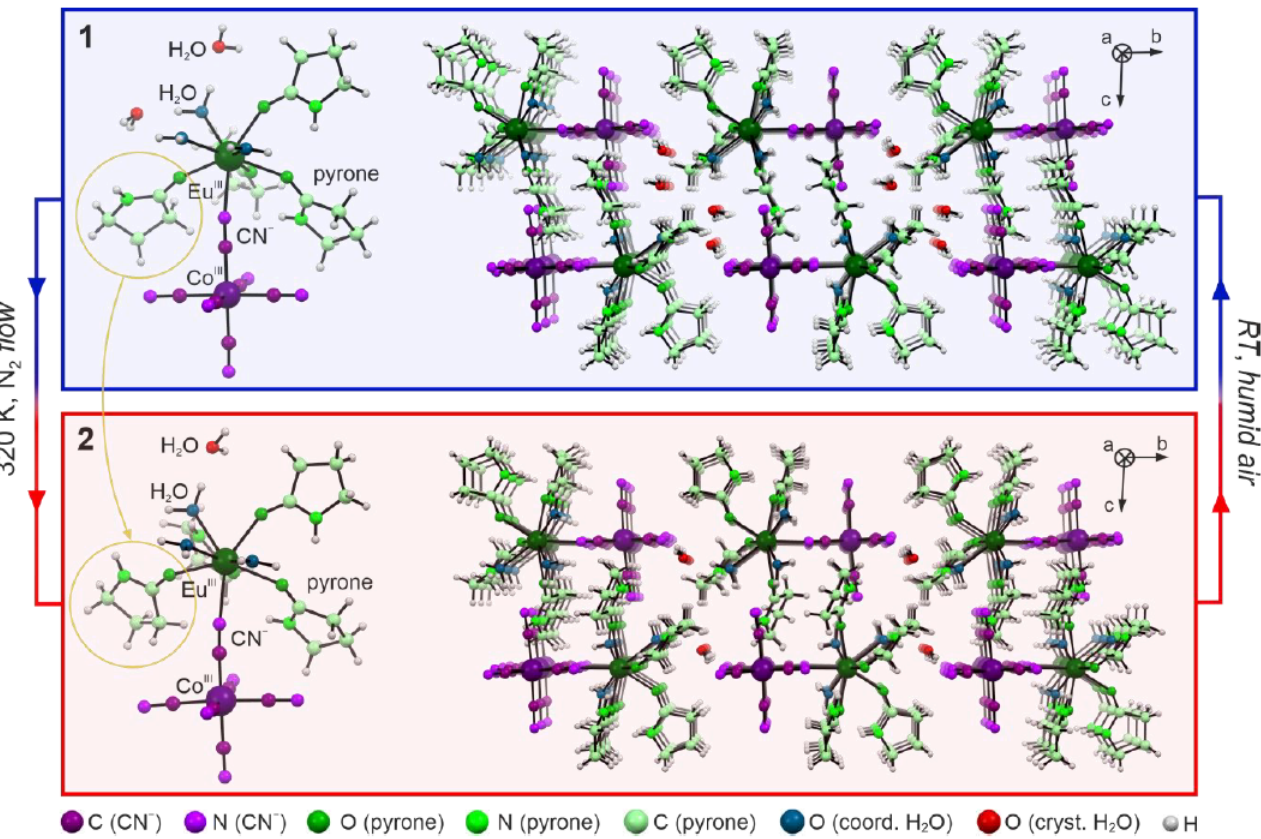
Figure 1. Representative views of the crystal structures of 1 and 2 . The graphic presents molecular building units of both structures ( left side ), and the crystal packing along a crystallographic axis ( right side ). The rotation of the pyrone ligand is highlighted by yellow circles. The experimental conditions of the observed transformation for a single crystal were placed in the figure. The Co- and Eu-atoms are labeled in the figure while the color code for all other atoms is shown at the